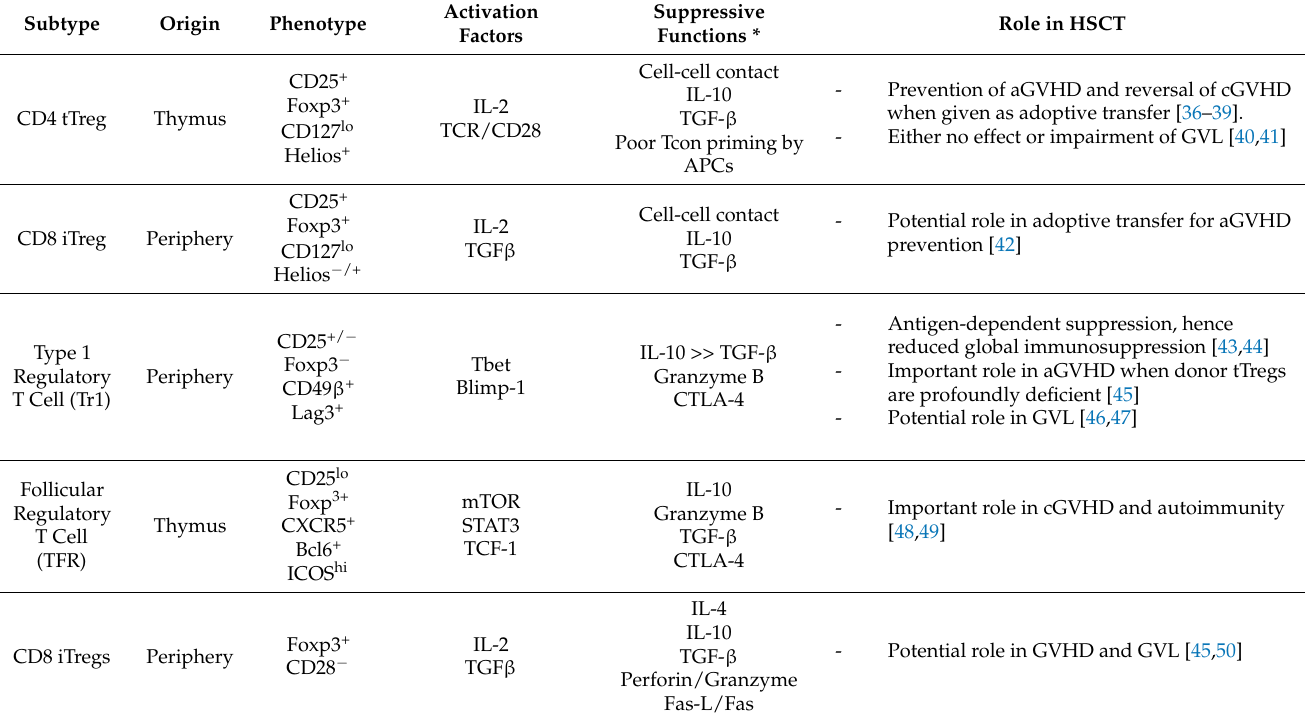
Table 1. Phenotypic and functional heterogeneity of regulatory T cells and their role in